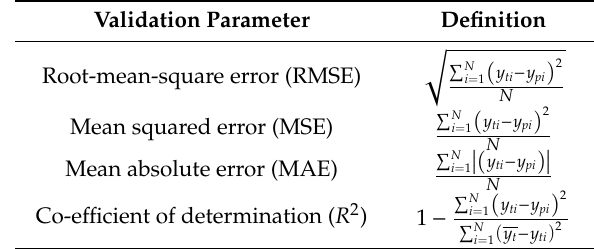
Table 1. Validation metrics used for regression. The regression results for both experiments are reported based on these metrics.